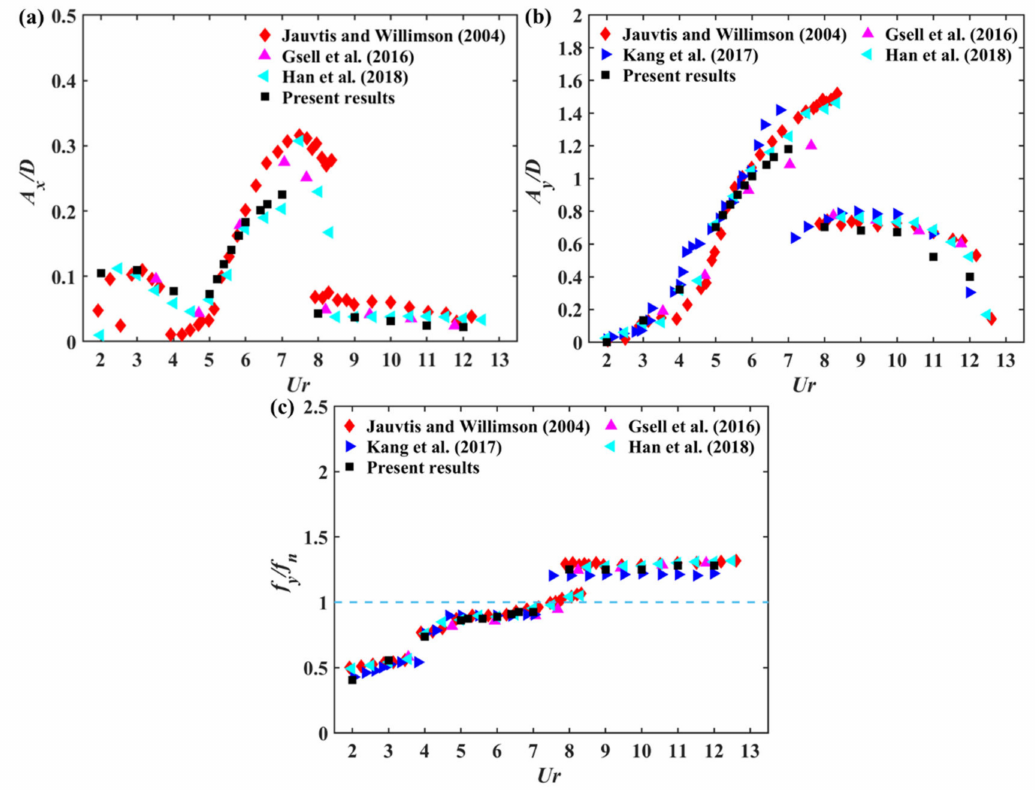
Figure 2. Comparisons of the response amplitudes and frequencies for the VIV of an isolated cylinder at different reduced velocities with references [2,4,5,31]: ( a ) streamwise amplitudes; ( b ) transverse amplitudes; ( c ) frequency ratio in the transverse direction. Table 1. Mesh dependence for the VIV of an isolated cylinder at Re = 20,000 and U r = 5. Mesh